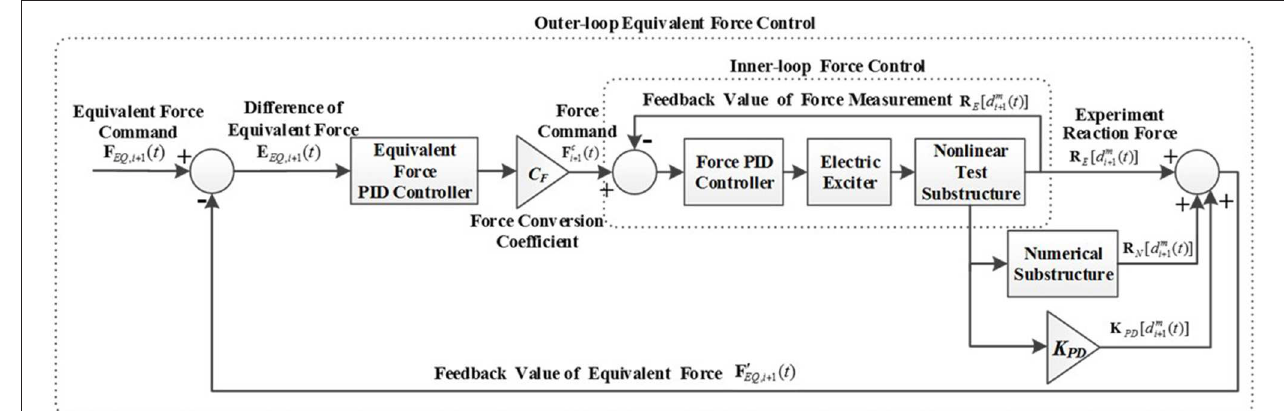
FIGURE 3 | Equivalent force control schematic